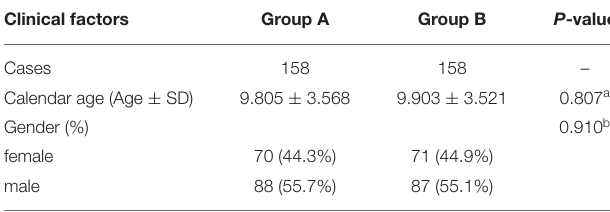
TABLE 1 | Characteristics of children in groups A and B.